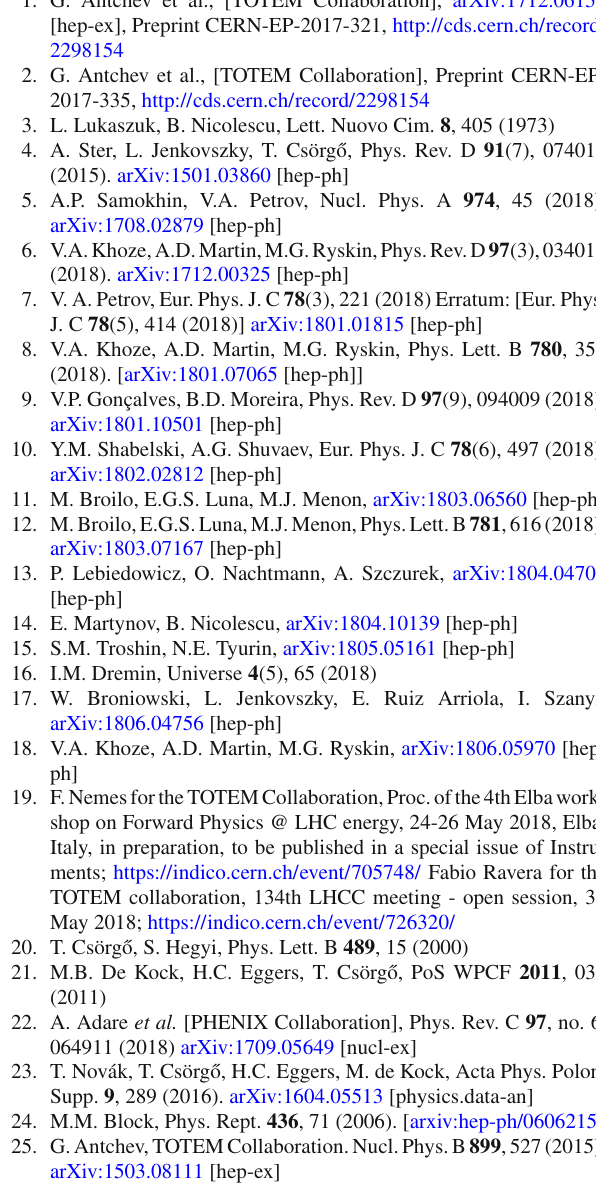
√ s = 7 TeV, with fixed